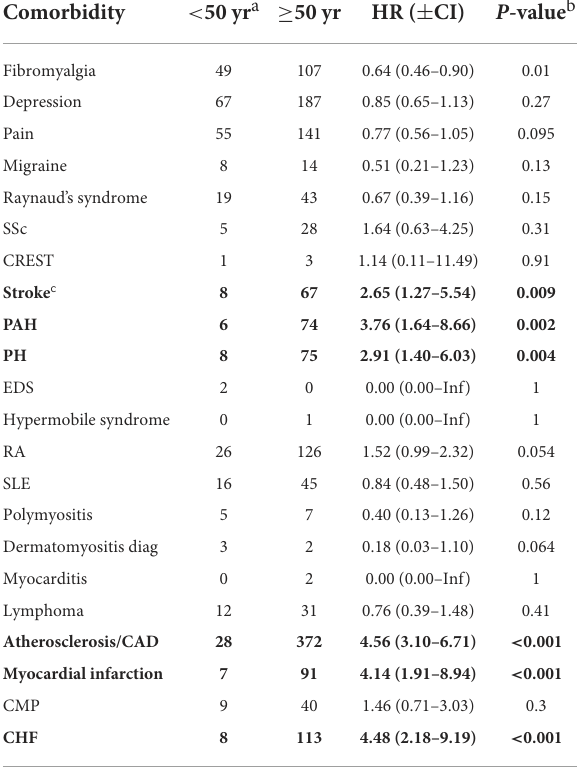
TABLE 14 Relative risk of developing a comorbidity in men with Sjögren’s disease that are ≥ 50 years of age ( n = 1,880).